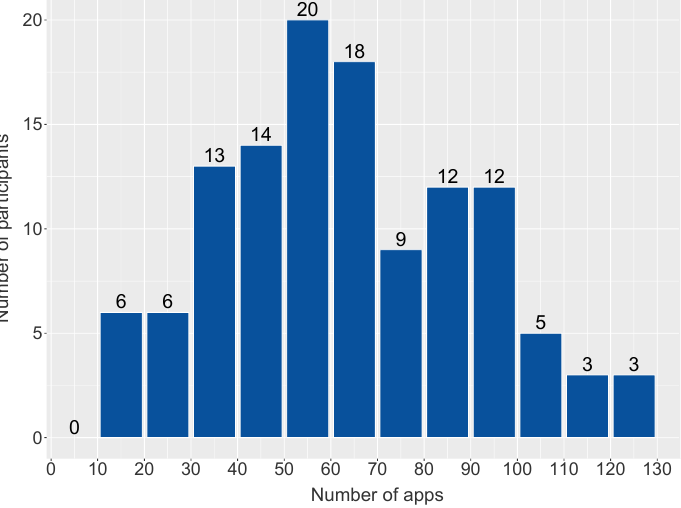
Figure 3. Number of apps on participants’ phones making a connection to an external server during the 30-day study, grouped in bins of 10. The majority of devices (60%) have between 30 and 70 apps making a connection to the internet over this period.